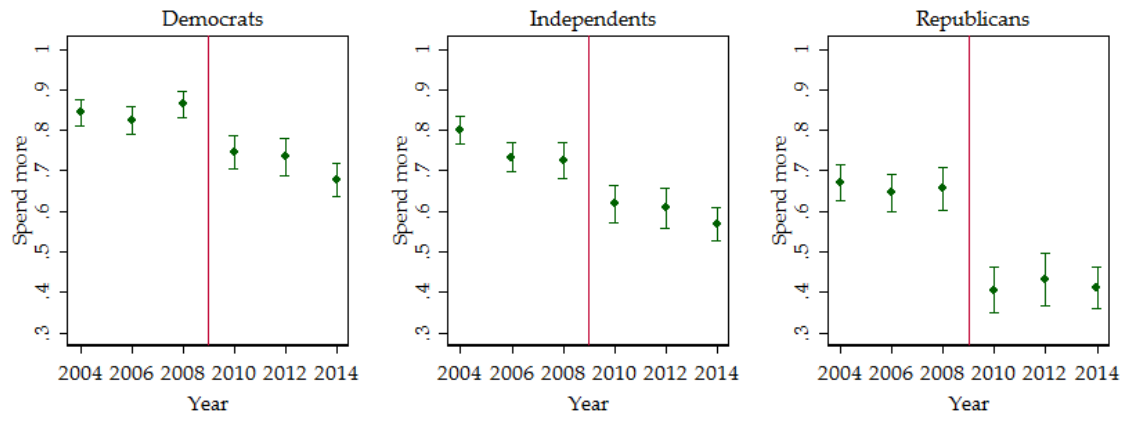
Figure 1: Proportion of respondents, by party identification, who indicate that “too little” money is spent on the nation’s